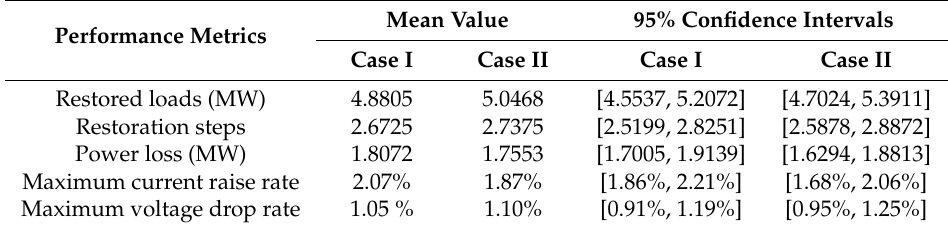
Figure 9. Impact of load restoration for case I and case II (our solution) ( a ) Maximum voltage drop; and ( b ) Maximum current raise. Table 5. Performance under multi-bus fault scenario with WT uncertainties (mean and 95% confidence